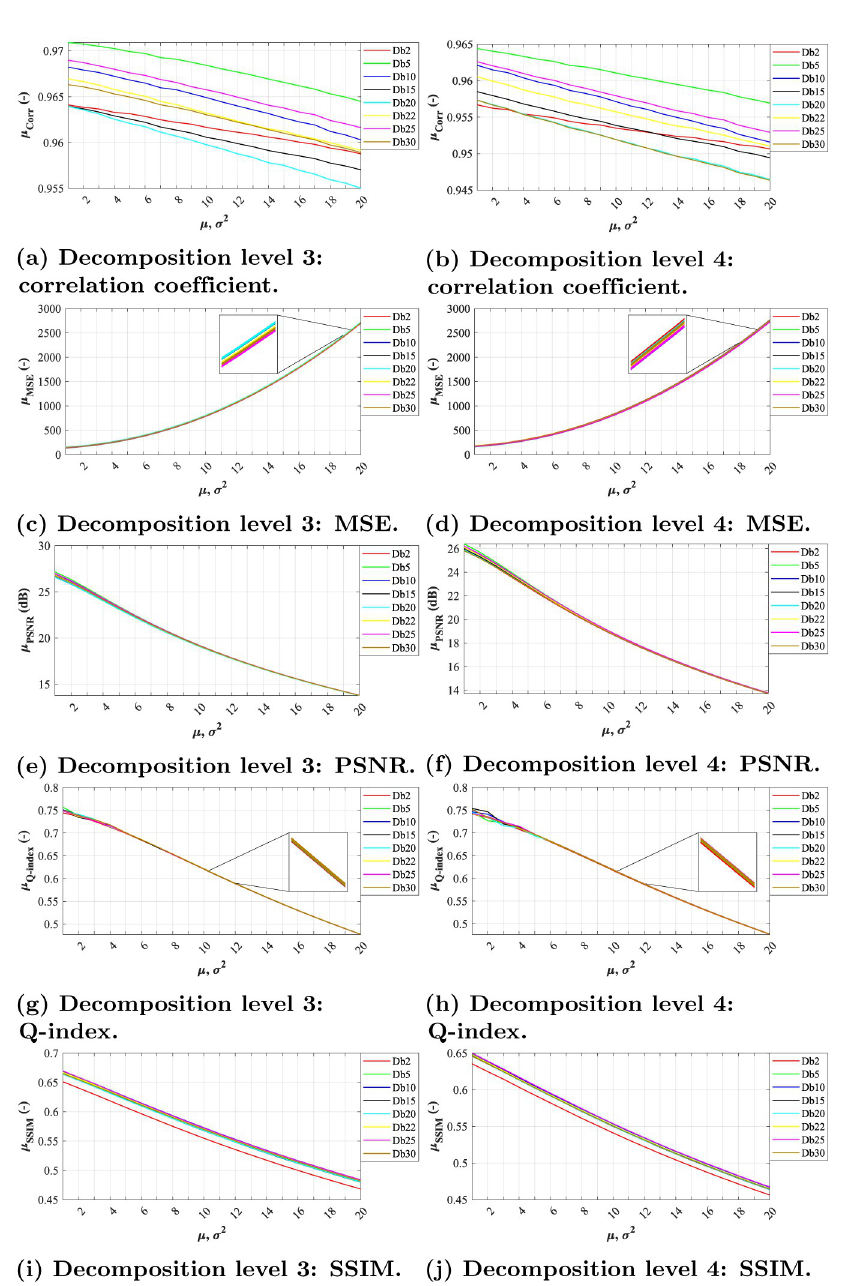
Fig 4. A comparative analysis of Gaussian noise ( σ 2 = 0.01, μ = {0.01, 0.02, ... , 0.20}) for Daubechies wavelets with decomposition level 3 and 4. (a) Decomposition level 3: correlation coefficient. (b) Decomposition level 4: correlation coefficient. (c) Decomposition level 3: MSE. (d) Decomposition level 4: MSE. (e) Decomposition level 3: PSNR. (f) Decomposition level 4: PSNR. (g) Decomposition level 3: Q-index. (h) Decomposition level 4: Q-index. (i) Decomposition level 3: SSIM. (j) Decomposition level 4: